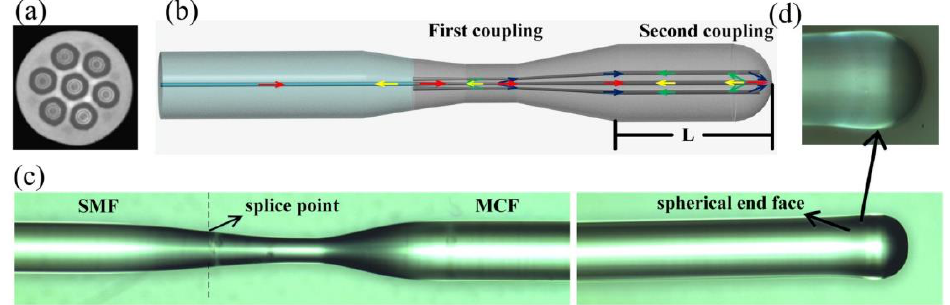
Figure 1. MCF sensor fabricated with tapering. ( a ) The cross-section image of the MCF. ( b ) Schematic diagram and operation principle of the Michelson-type multipath interferometer. ( c ) MCF-MI structure under microscope. ( d ) Spherical end face of MCF under microscope. Reprinted with permission from Ref. [34] © 2016 Optica Publishing